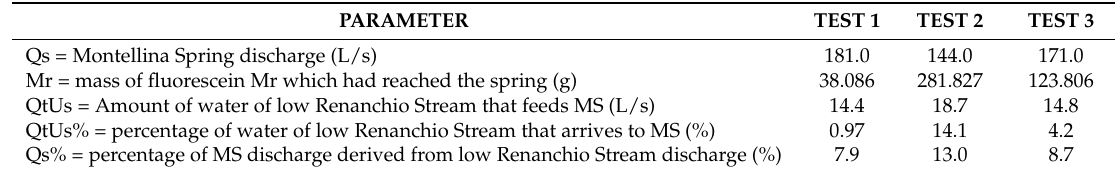
Table 5. Summary table of tracer tests results with fluorescein (Test 1 in July 2011, Test 2 in September 2011, and Test 3 in November